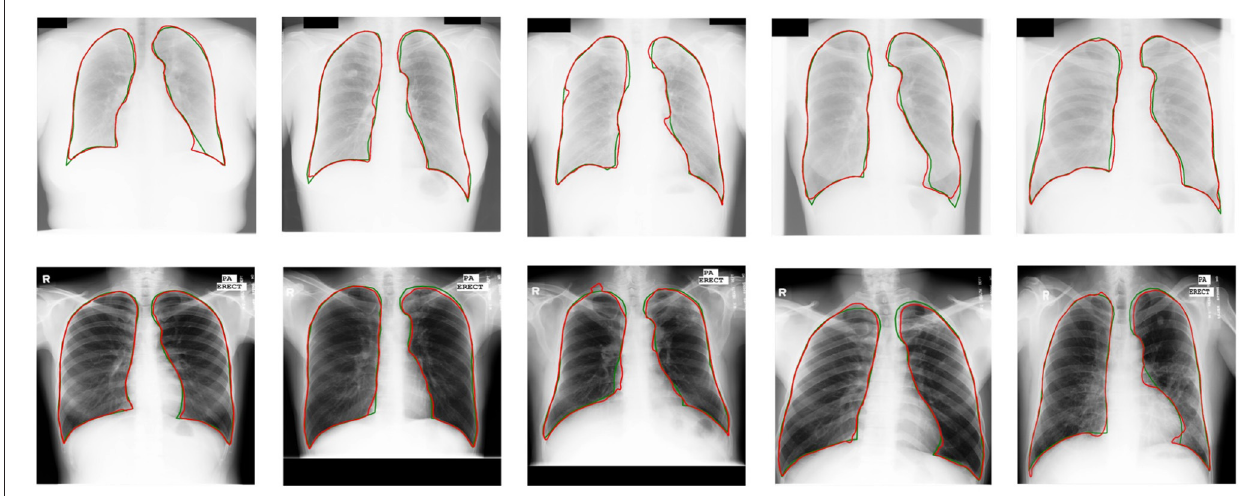
FIGURE 6 | UDA results with U-shaped GAN. The radiographs from the JSRT dataset with MC → JSRT UDA results are on the top; the radiographs from the MC dataset with JSRT → MC UDA results are on the bottom. Green and red contours indicate the ground truth and automatic segmentation results, respectively.